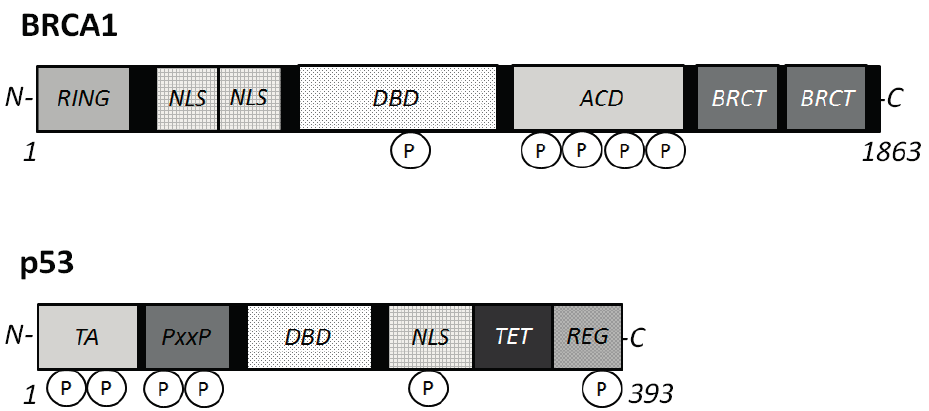
Figure 2. Schematic structures of BRCA1 and p53 proteins. The predicted